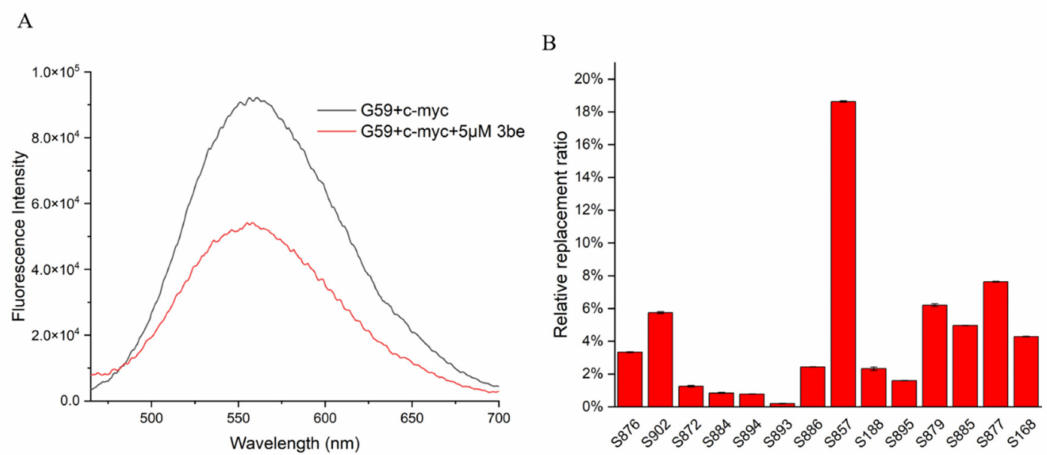
Figure 5. Application of G59 for screening c-myc i-motif binding ligands. ( A ) Fluorescent spectra for mixture of 1 µ M G59 and 2 µ M c-myc i-motif, with or without addition of 5 eq (5 µ M) 3be in 1 × BPES buffer at pH 5.5. ( B ) Relative G59 replacement ratio was used for screening natural products for potential c-myc i-motif binding